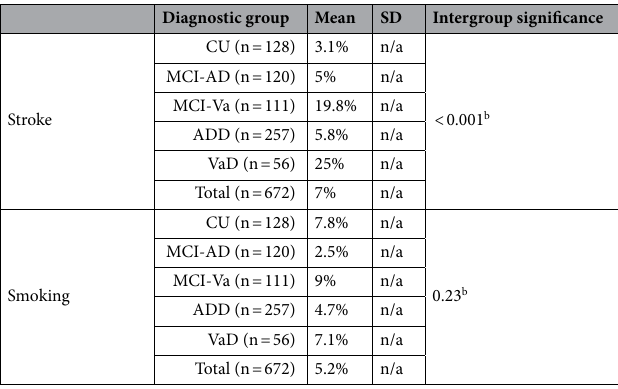
Table 1. Demographic and clinical characteristics of the cohort. Demographic and medical conditions among groups are summarized. a 1-factor ANOVA b Pearson’s Chi2 test. ADD = probable Alzheimer´s disease dementia; COPD = chronic obstructive pulmonary disease; CU = cognitively unimpaired; MCI-AD = mild cognitive impairment due to Alzheimer´s disease; MCI-Va = mild cognitive impairment due to cerebrovascular pathology; MMSE = Mini Mental State Examination; n/a = not available; SD = standard deviation; VaD = vascular dementia. Significance was set up at p <